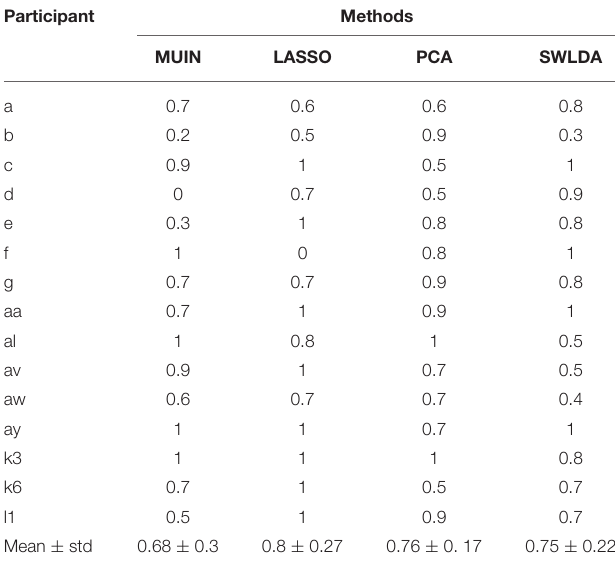
TABLE 2 | Ratio comparison of samples with selected features from different time windows to the total